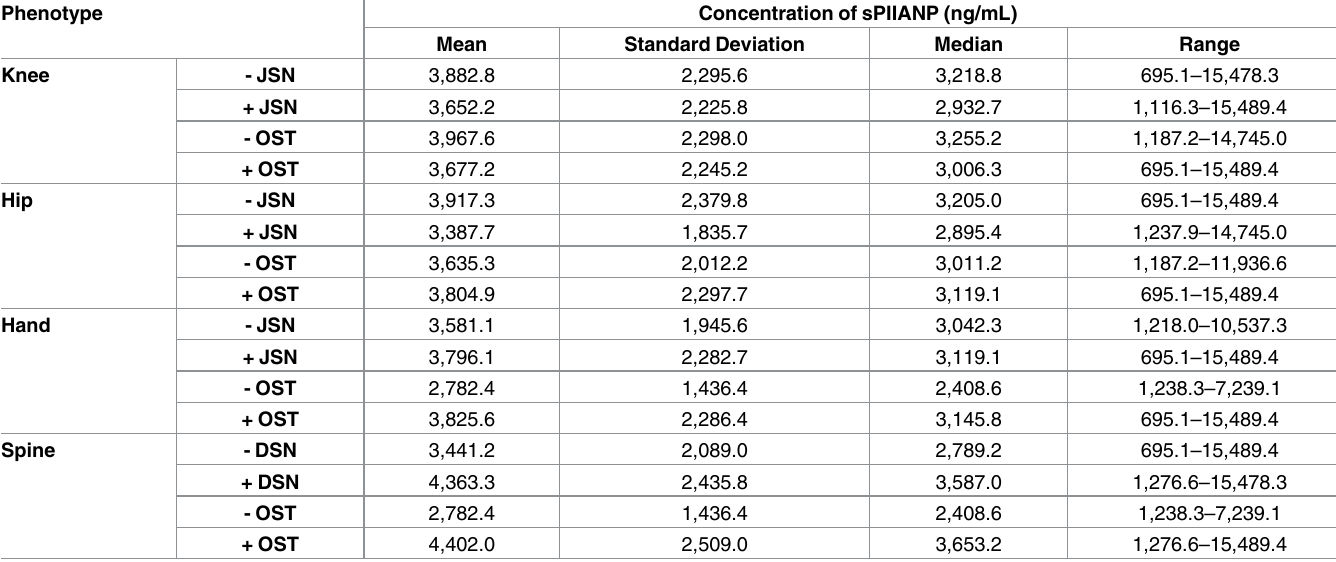
Table 2. Serum PIIANP concentrations of participants with and without OA